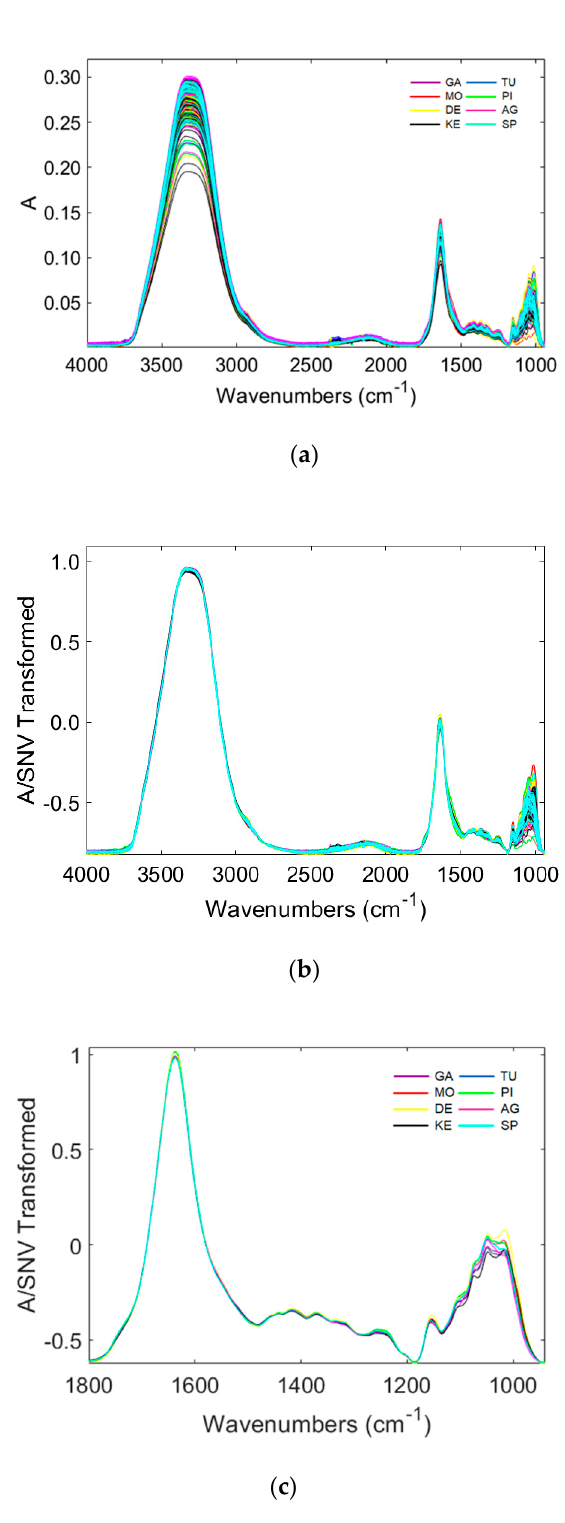
Figure 5. ( a ) Raw and ( b ) standard normal variate (SNV)-scaled attenuated total reflectance Fourier transform infrared (ATR-FTIR) spectra of potato samples. ( c ) Mean SNV-scaled spectra in the 1800–940 cm − 1 range for each accession. A: Absorbance.